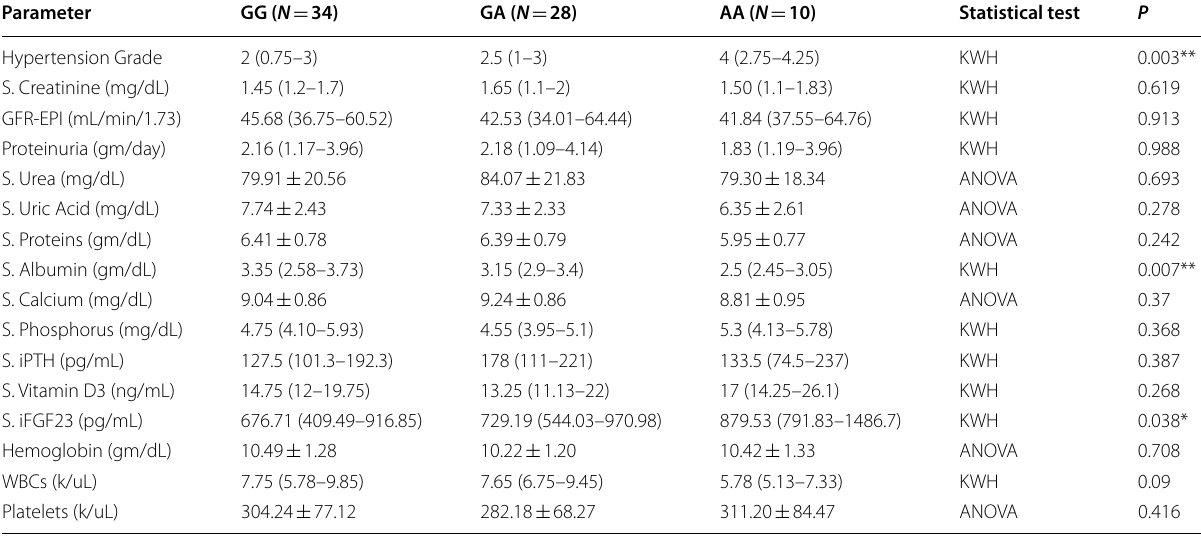
Table 3 Comparison between CKD patients regarding FGF23 RS7955866 polymorphism genotypes